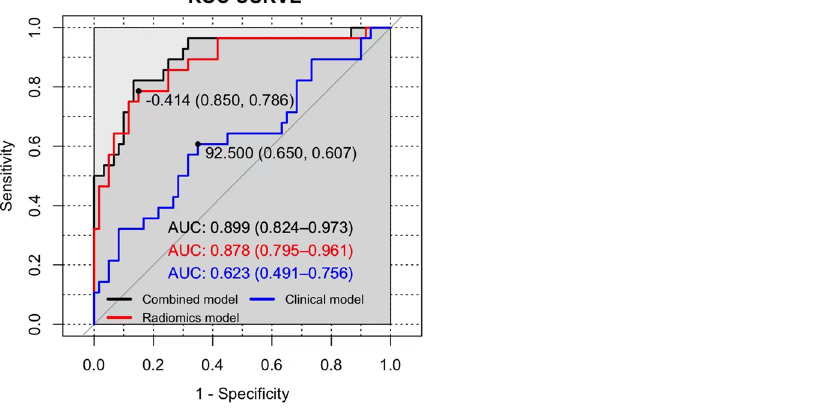
Figure 3. Comparison of ROC curves for the three models’ differentiation for predicting pathological grading.